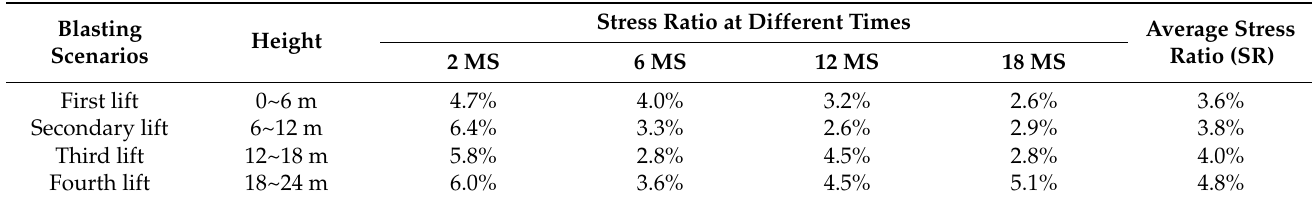
Figure 10. Equivalent stress ratio of ORE and CPB on HRCB: ( a ) the first lift blast; ( b ) the secondary lift blast; ( c ) the third lift blast; ( d ) the fourth lift blast. Yellow is the von Mises stress of the ore element, blue is the von Mises stress of the CPB element at the corresponding position, and the stress bar of the CPB element is magnified by five times for observation. Table 3. Statistical results of the layered lift blasting stress